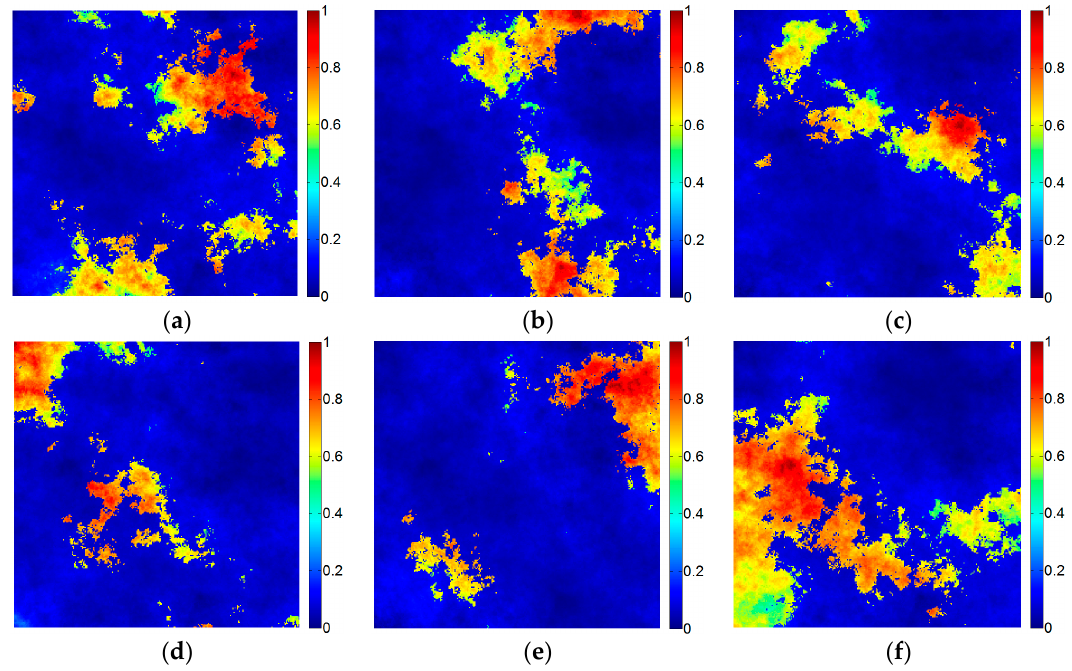
Figure 3. Abundance distributions considered for generating the simulated hyperspectral scene. ( a ) Abundance of Endmember 1; ( b ) abundance of Endmember 2; ( c ) abundance of Endmember 3; ( d ) abundance of Endmember 4; ( e ) abundance of Endmember 5; ( f ) abundance of Endmember 6. Table 1. Comparison between the Spectral Angle Distance (SAD) values of N-FINDR, Vertex Component Analysis (VCA), Discrete Particle Swarm Optimization (D-PSO), and MOAQPSO. SAD N-FINDR VCA